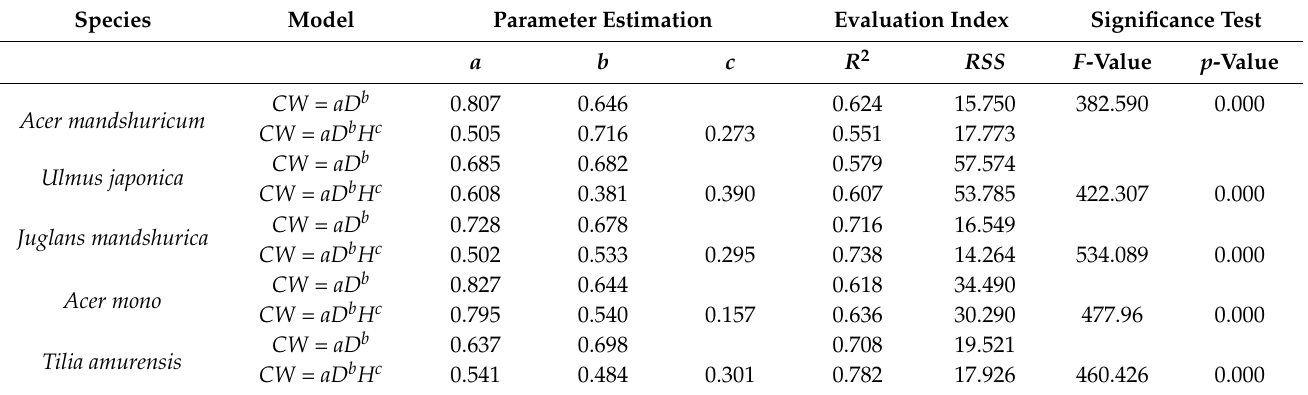
Table 1. Parameter estimation of prediction models and significance testing of optimal models.